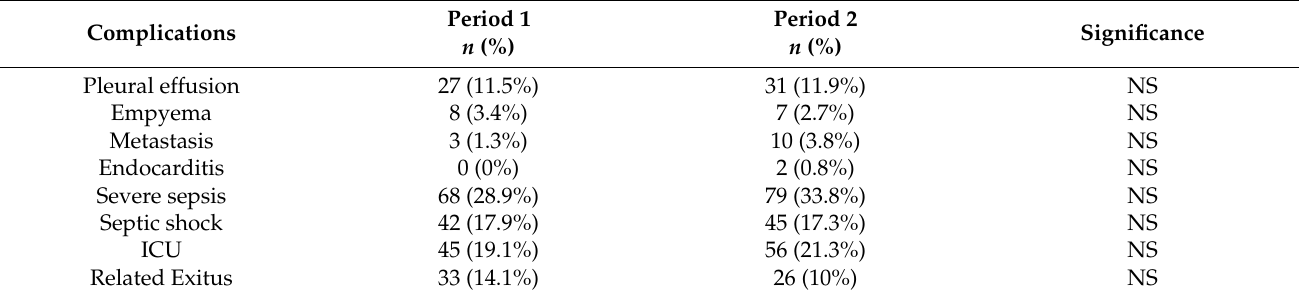
33 (14.1%) 26 (10%) NS Exact Fisher test or Chi-square